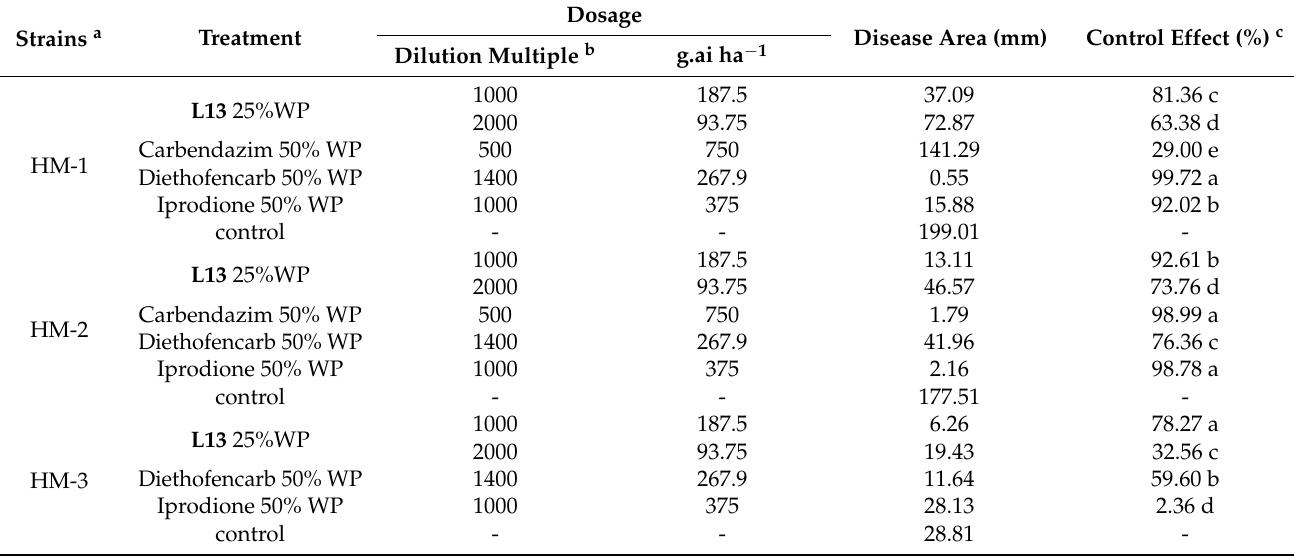
Table 1. Control effect of L13 against B . cinerea resistant to commercial